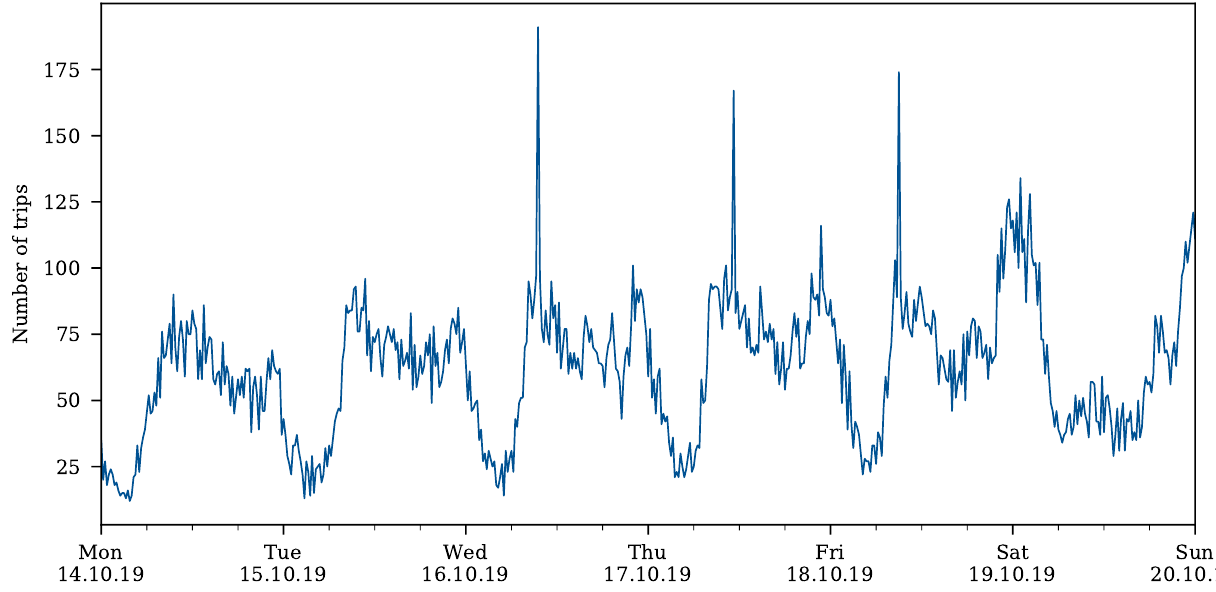
Figure 5. Number of Taxi Trips during Example